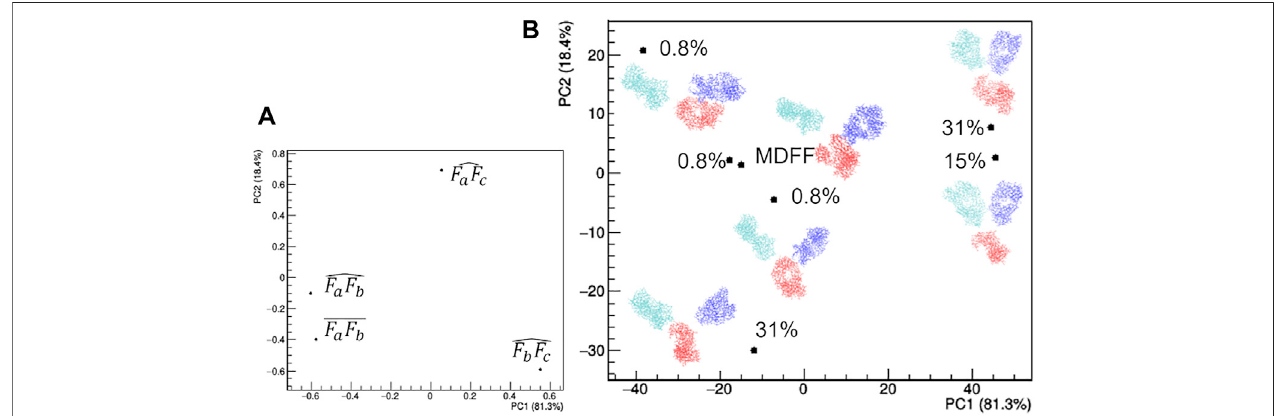
FIGURE 7 | Comparison of the structural models generated by the ensemble optimization method based on principal component analysis (PCA) of related geometrical features. (A) PCA loadings values showing the individual geometrical parameters in discriminating the models; (B) PCA scores values showing the model discrimination.Themodelsaredrawnnexttotheirrepresentativepoints,withFa,FbandFccolouredincyan,blueandred,respectively,togetherwiththeirrelativeweight intheEOMensemble.Thefractionofthetotaldatavarianceexplainedbythe fi rst(PC1)andsecond(PC2)principalcomponentisreportedonrelativetheaxesofthe loadings (A) and scores (B) plots.